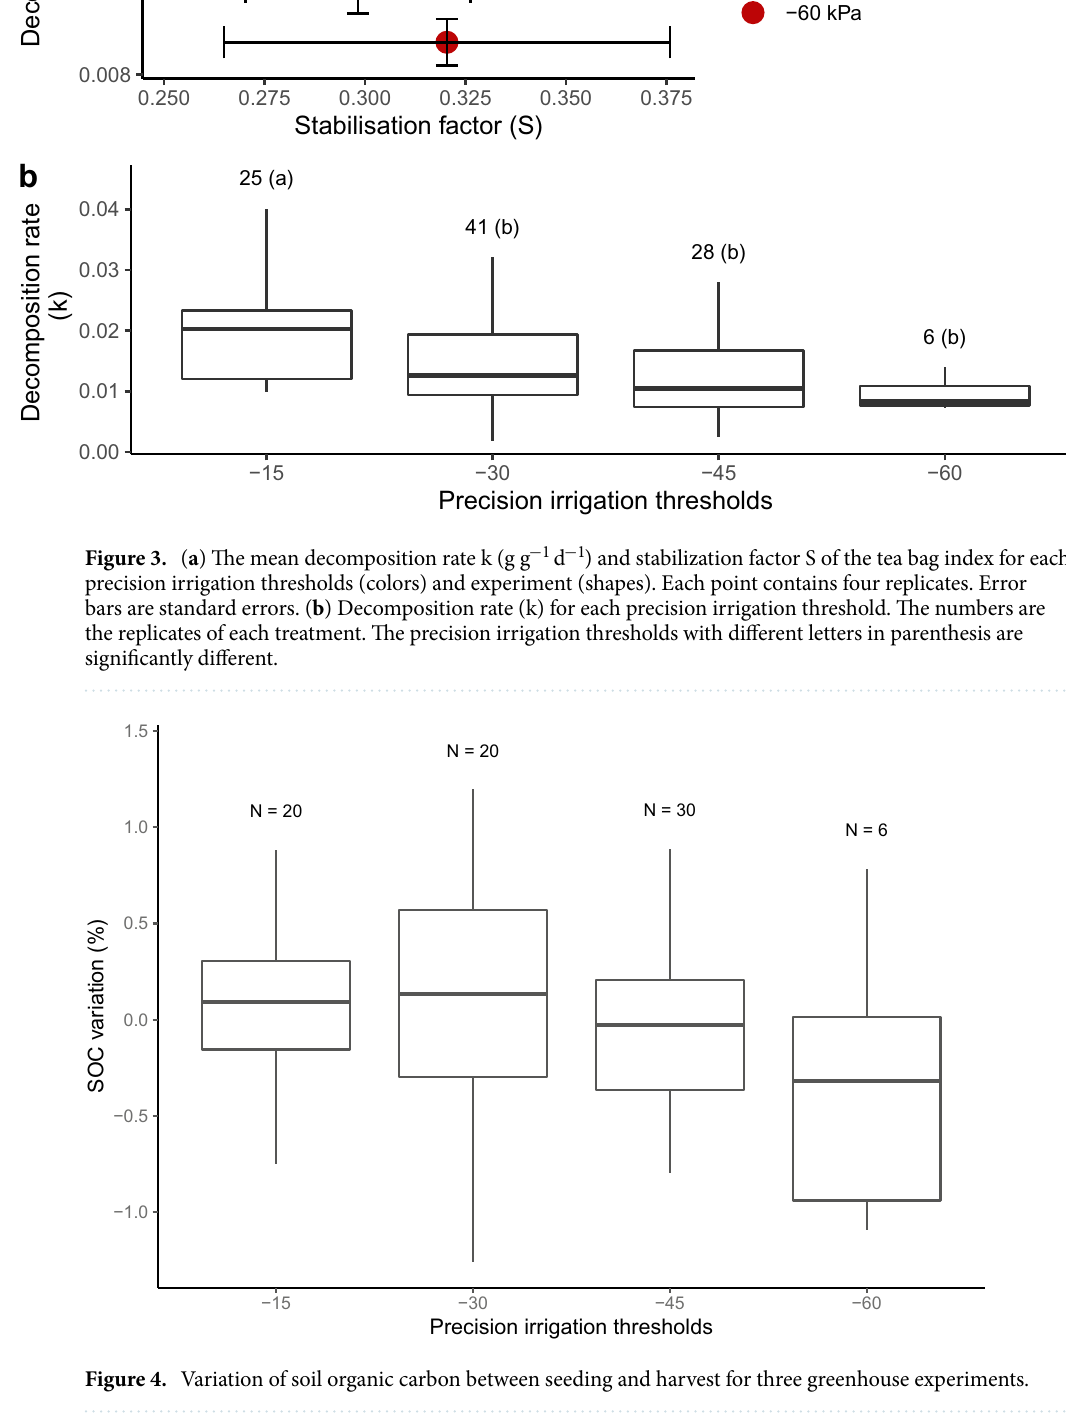
Figure 4. Variation of soil organic carbon between seeding and harvest for three greenhouse